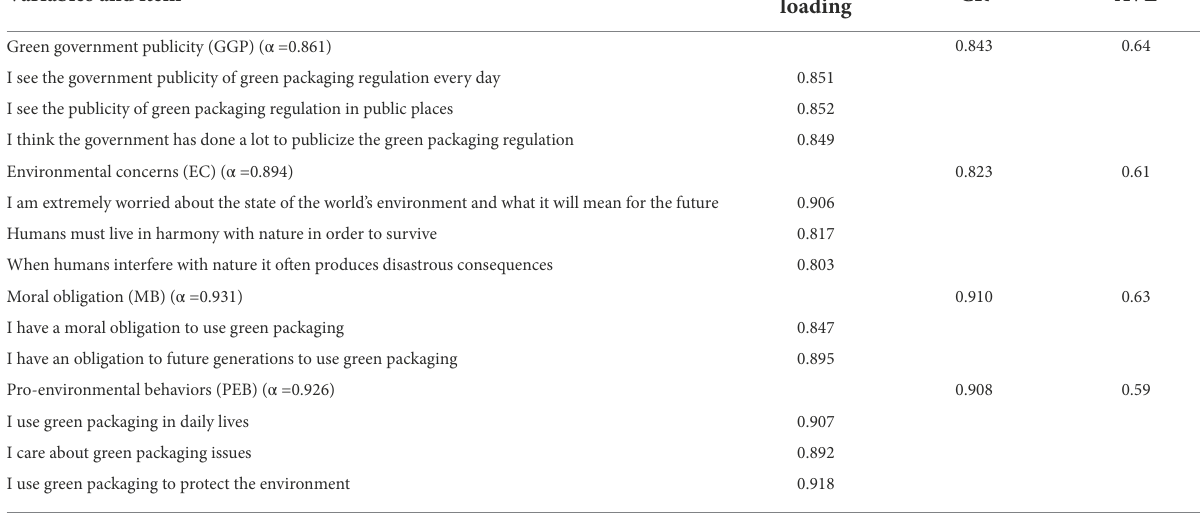
TABLE 1 Measurement model assessment. Variables and